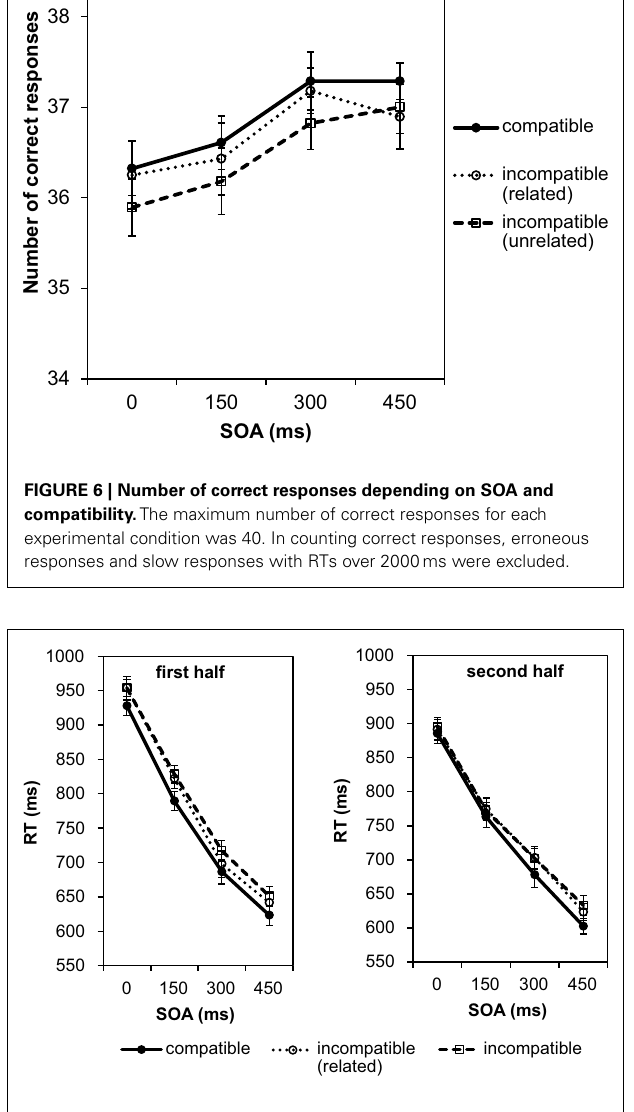
FIGURE 7 | Mean reaction times depending on SOA and compatibility in Experiment 3. The data are shown separately for the first half of the test phase (left graph) and the second half of the test phase (right